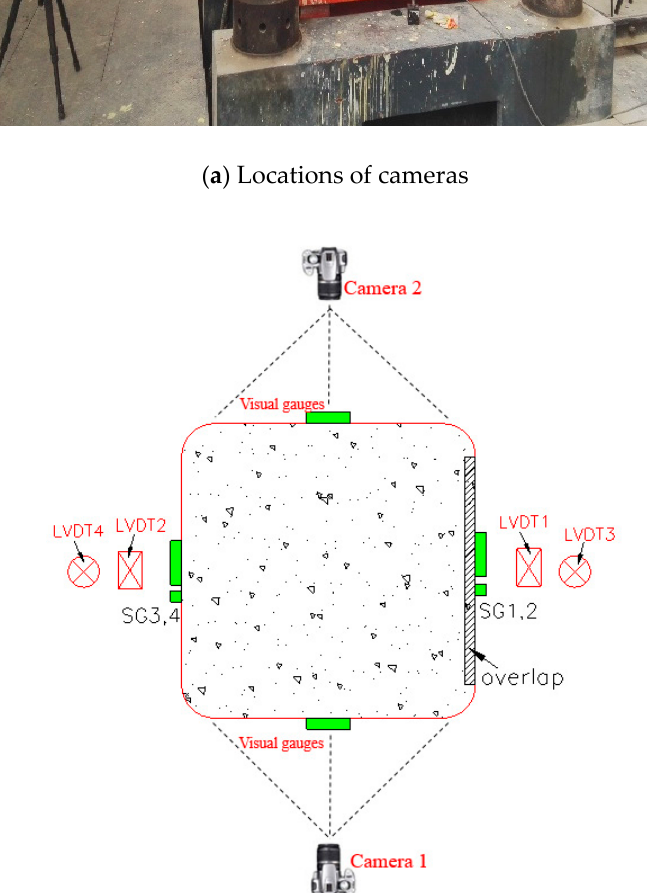
Figure 4. Strain measurement using the particle image velocimetry (PIV) sensing technique.